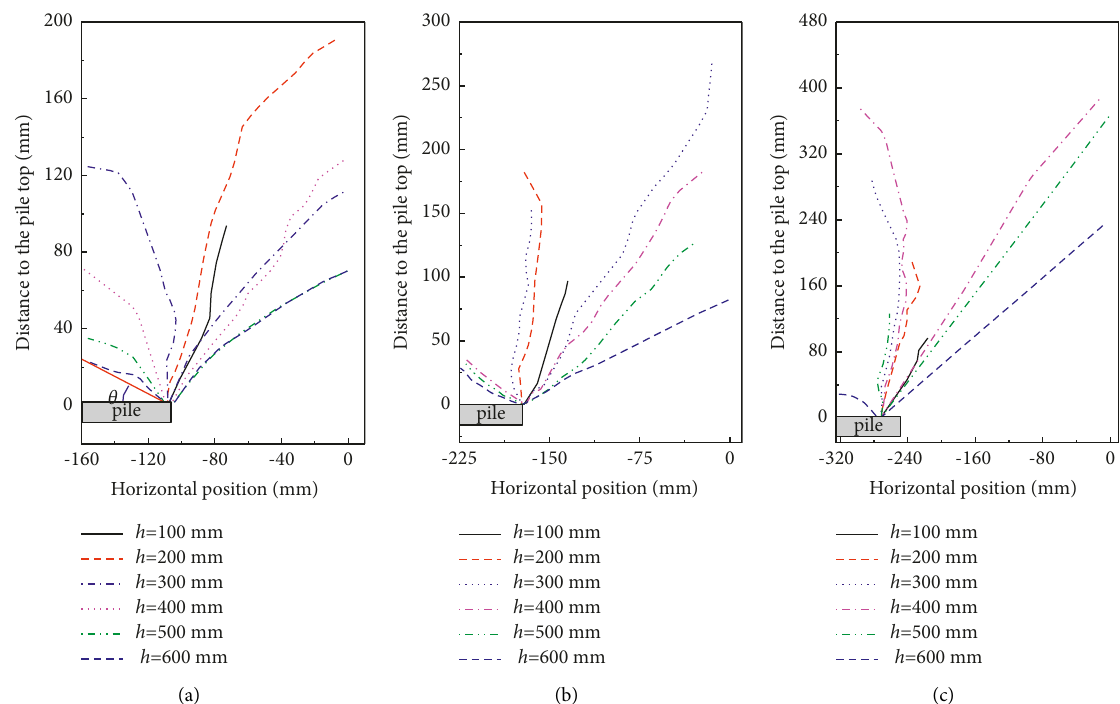
Figure 9: Evolution of the failure surfaces with various embankment height for different pile-net spacing: (a) (s)-(b) � 220mm, (b) (s)-(b) � 350mm, and (c) (s)-(b) � 550mm.